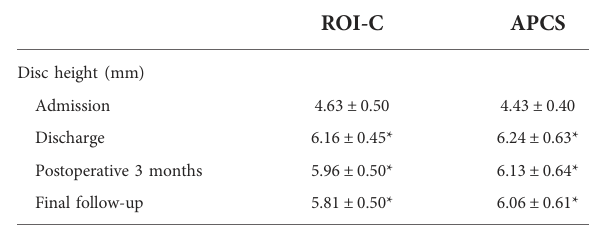
TABLE 2 Clinical assessment of JOA, NDI, ASIA scores and radiographic measurement.